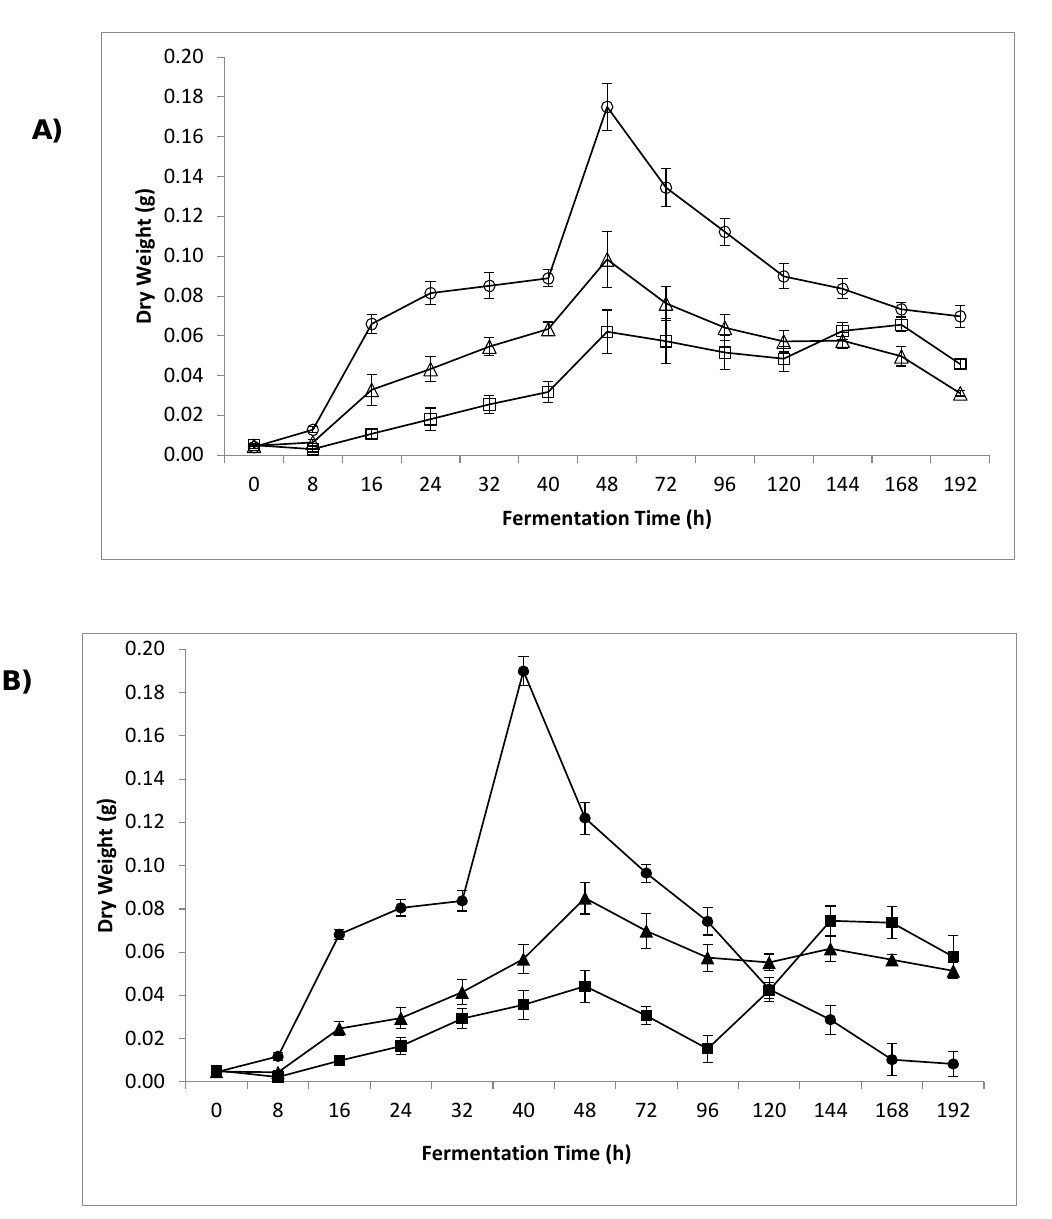
Figure 4. ( A ) Dry weight (g) of a 50-mL sample of non-NaCl-stressed cells during various fermentation times (h) with three different media containing 200, 300, or 400 g/L glucose ( n = 3 replications for each time and error bars represent standard deviation of the average value of all replications with each range of fermentation time); ( B ) Dry weight (g) of a 50-mL sample of non-NaCl stressed cells during various fermentation times (h) with three different media containing 200, 300, or 400 g/L glucose ( n = 3 replications for each time and error bars represent standard deviation of the average value of all replications with each range of fermentation time) ( ): (200 g/L glucose, 0% NaCl), ( ∆ ): (300 g/L (cid:35) glucose, 0% NaCl), ( (cid:3) ): (400 g/L glucose, 0% NaCl), ( ): (200 g/L glucose, 6% NaCl), ( (cid:78) ): (300 g/L glucose, 6% NaCl), ( (cid:4) ): (400 g/L glucose, 6% NaCl). The β -Glucan yield (g) was optimum for media (200 g/L glucose, 0% NaCl), (200 g/L glucose, 6% NaCl), (300 g/L glucose, 0% NaCl) and (300 g/L glucose, 6% NaCl) at the stationary